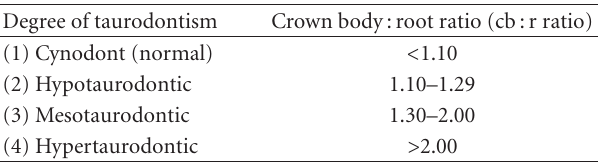
Table 2: Crown body: root ratio classification according to